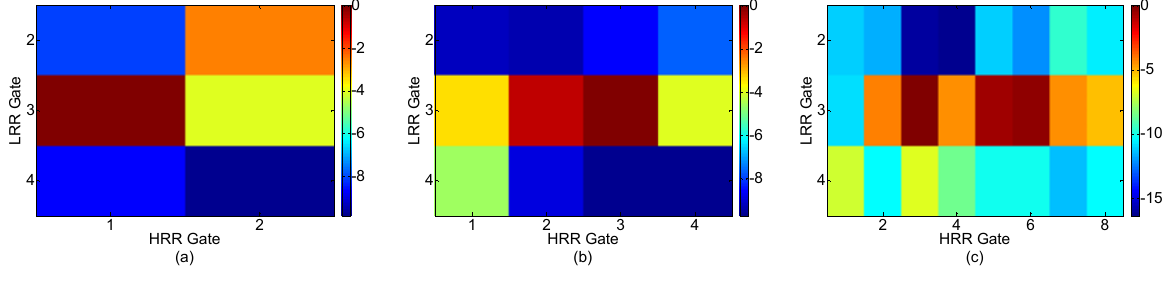
Figure 14. HRR images for Target Scenario 6. ( a ) Pass 2, Target scene 1. ( b ) Pass 3, Target scene 1. ( c ) Pass 4, Target scene 1. ( d ) Pass 5, Target scene 1. ( e ) Pass 2, Target scene